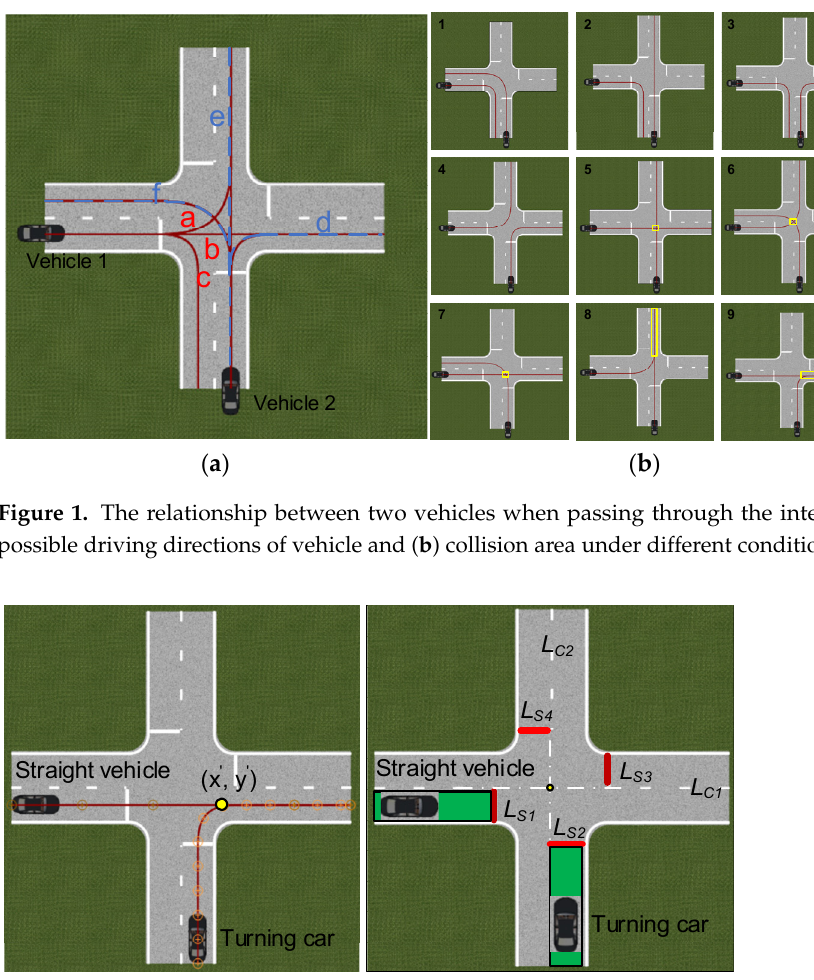
Figure 2. Road-geometry model of intersection confluence condition.